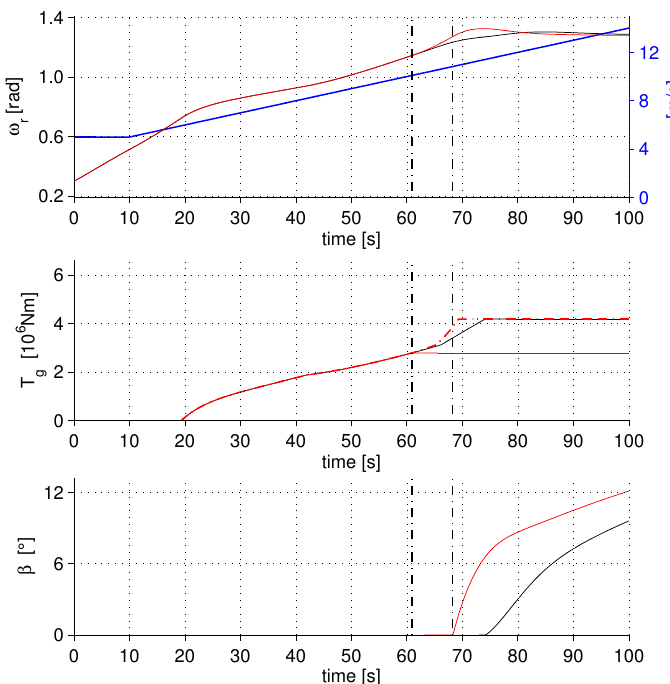
Figure 8. Rotor acceleration test in partial, transition and full load region: fault-free case, n = N (black line) and faulty case n = 8 (red line), wind speed (blue line).